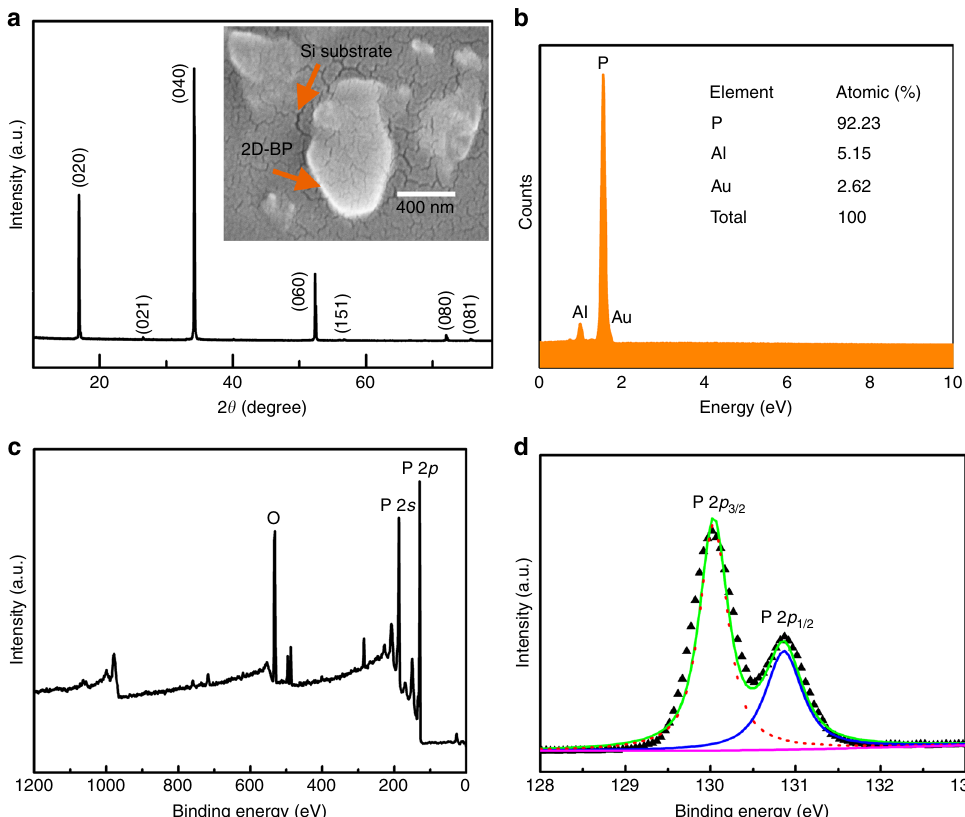
Fig. 2 Microscopy and spectroscopy of 2D-BP. a XRD patterns. The inset is the SEM image. b EDS spectrum. c XPS spectrum in a wide energy range. d P 2 p core level XPS